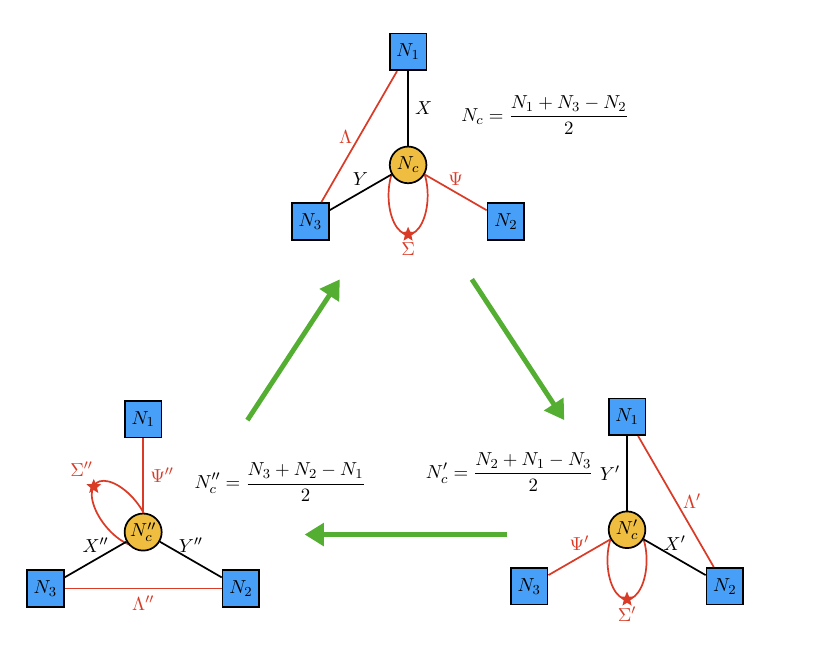
Figure 5 . Triality loop for 2 d N = (0 , 1)